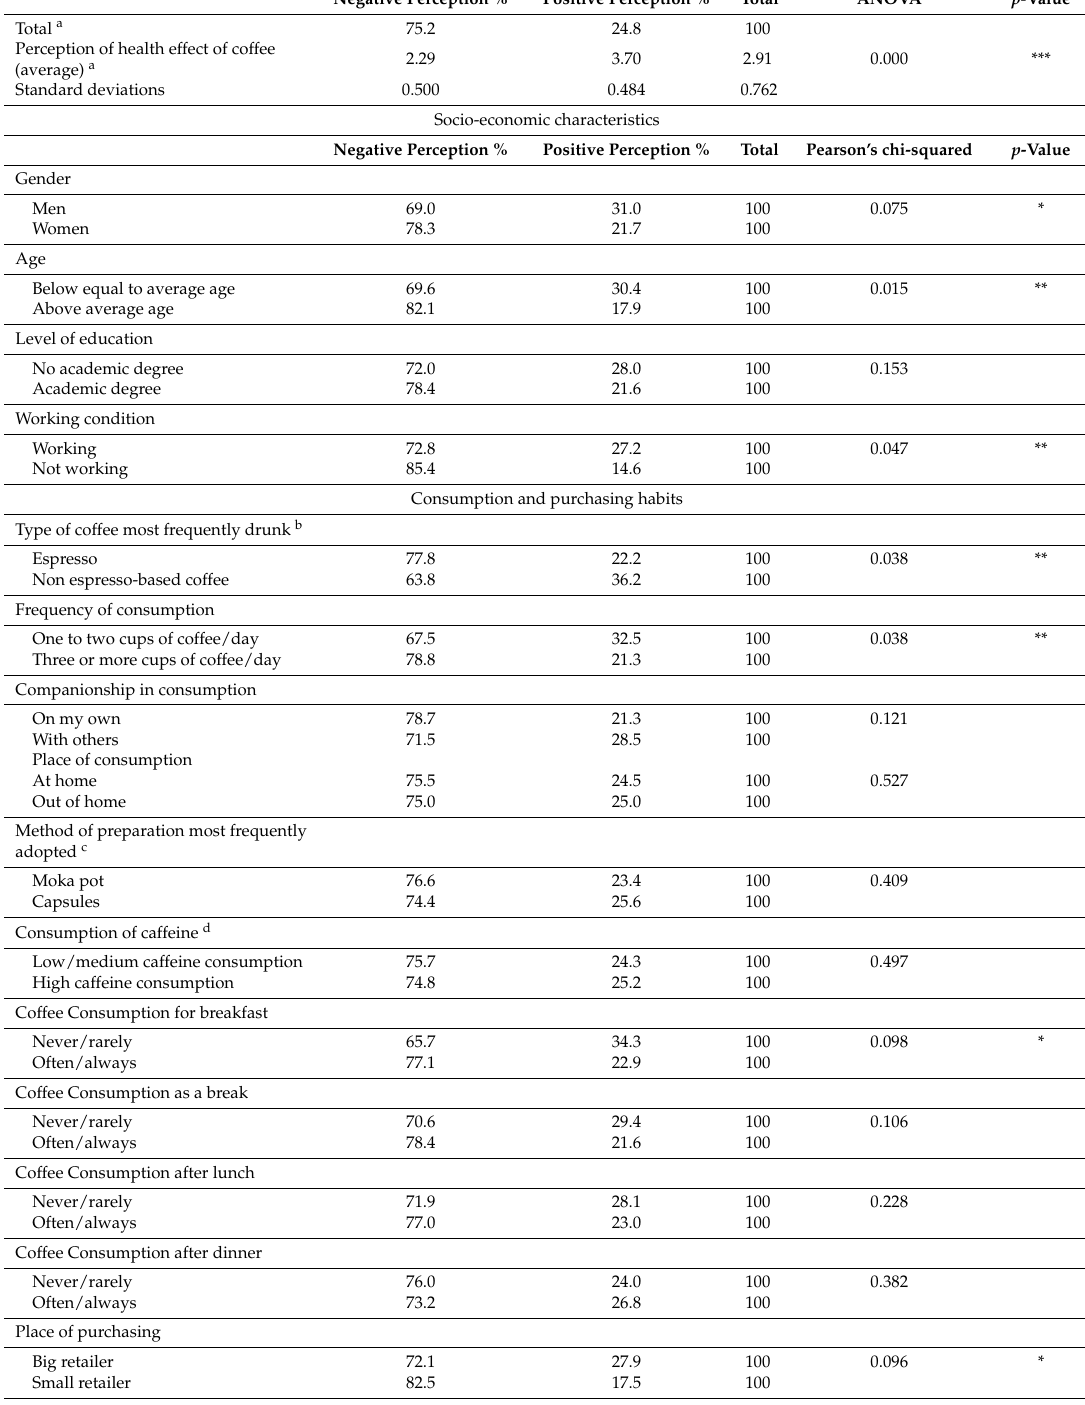
Table 4. Consumers’ perceptions of health effect of coffee consumption and consumers’